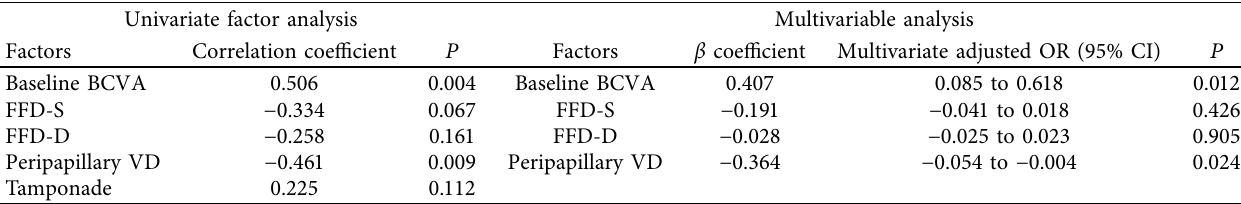
Table 4: Univariate and multivariate analysis of factors associated with postoperative